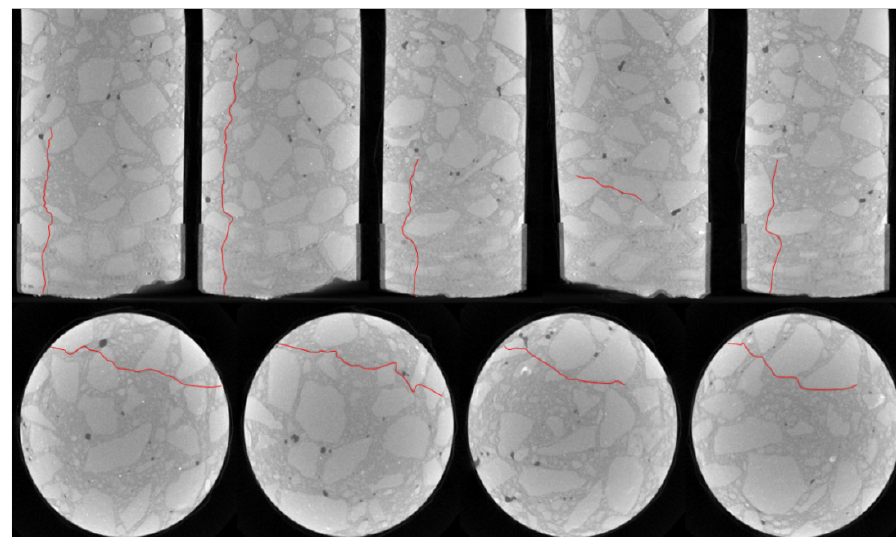
Figure 5. Type-II microcrack .